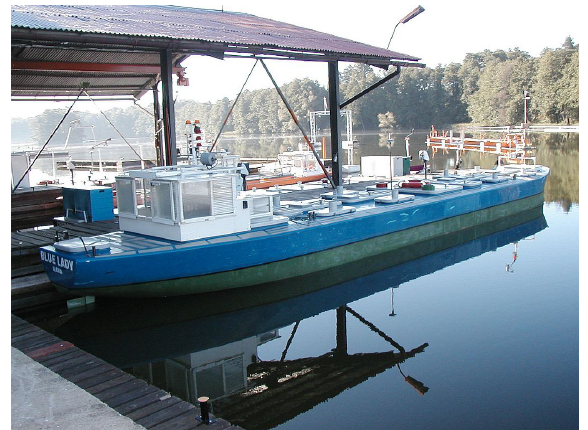
Figure 2. Picture of lardboard the training ship ‘Blue